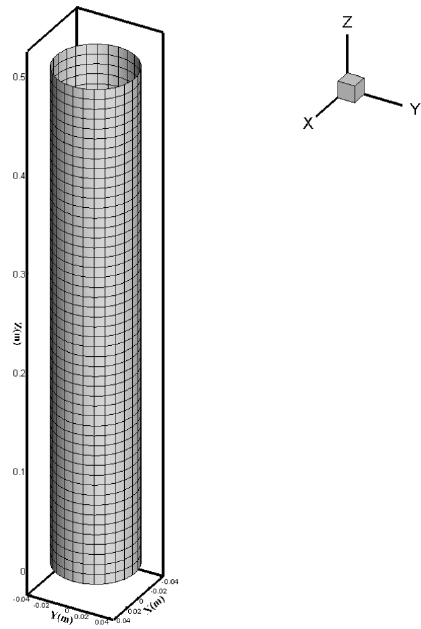
Figure 3. Experimental fluidized bed configuration.